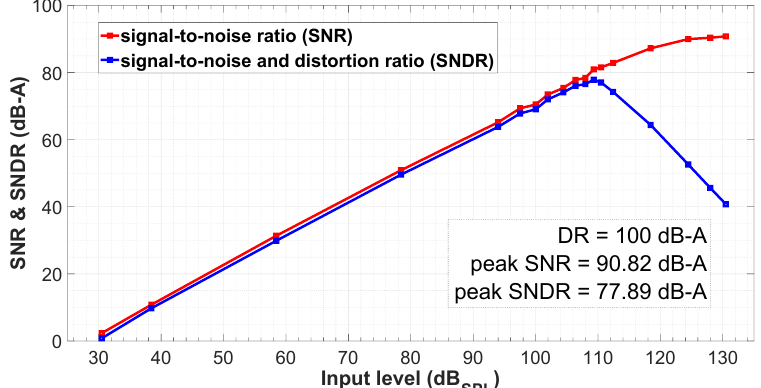
Figure 12. Measured dynamic range for different input levels referred to 94 dB SPL = 12 mV rms (A-Weighting filter applied).